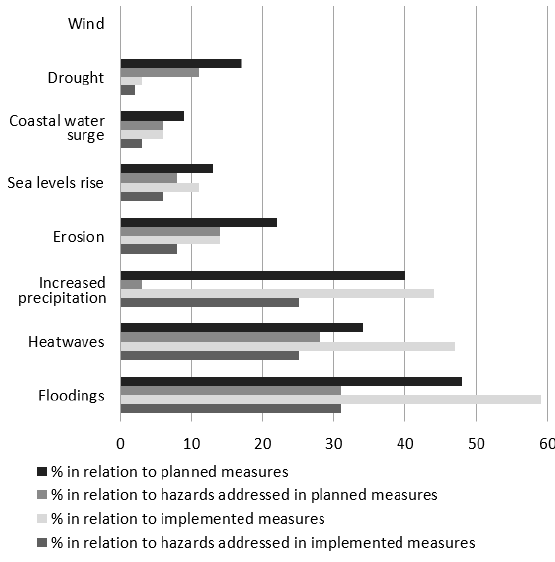
Fig. 5 . Hazards addressed by identified measures. Multiple categorizations of single measures are included.